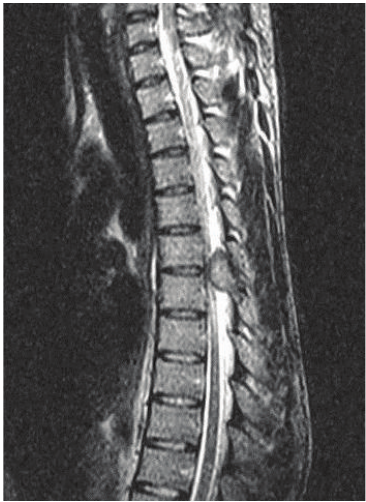
Figure 1: Sagittal T2-weighted images show expansive mass lesion involving the posterior elements of T6 and T7 vertebrae.